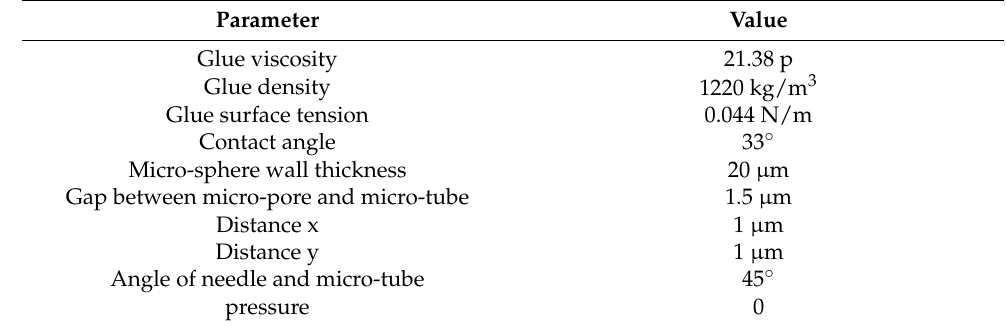
Table 2. Experimental parameters of dispensing.